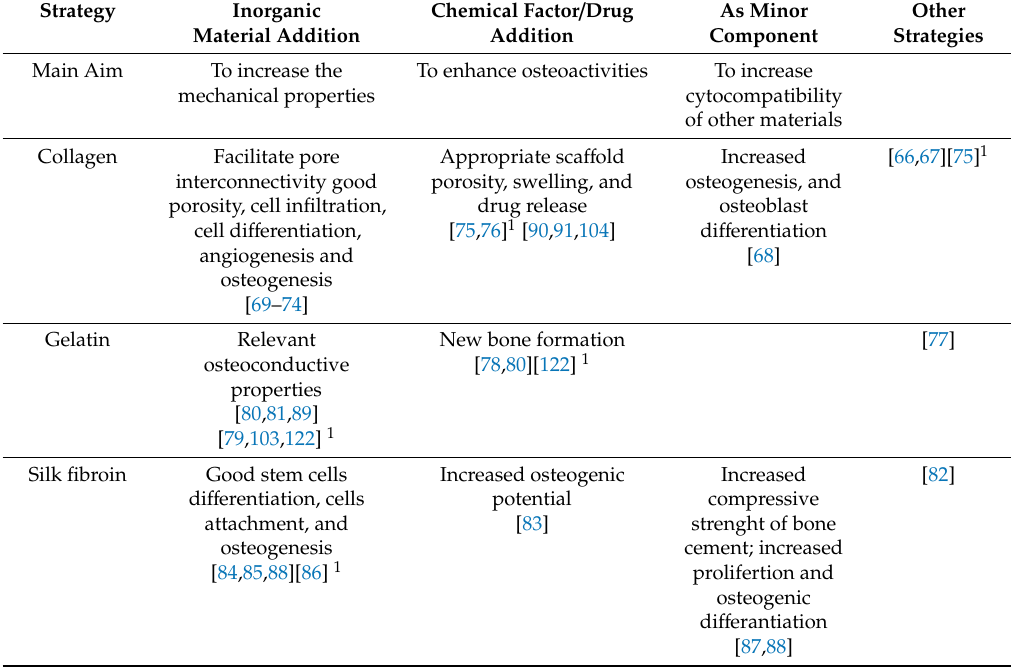
Table 5. In vitro and in vivo experiments are classified according to the material and the strategy adopted with the aims of enhancing the sca ff olds performances. In the first row the main strategies used to make the polymers suitable for bone sca ff olds are reported. In the second row, the fundamental common aim for each strategy. All the analyzed studies in this review have been here classified according to both the material and the strategy adopted. In addition to the achieved general aim, the relevant evidences specific for each combination of material and strategy have been resumed in the table. Almost half of the reported studies overcame the polymers main limit of low mechanical feature by addition of inorganic materials (second column). This strategy not only guanteed an increased mechanical strenght but also favored the cells activities, as specifically reported for each material-strategy combination. In the third column, the several studies involving chemical factors / drugs addition to enhance the polymers osteoactivies. In the fourth column are reported the references where polymers - mainly the natural ones - are used as minor component to enhance the bioactivity or as reinforcement (only in silk and cellulose cases) of other bulk materials. Just few studies can not be included according to the described criteria and are reported in the firth column. The residual number of the studies in the “other stretegies” column confirmed the reported strategies as the most applied ones to obtain the ideal sca ff old, that aim to both overcome the polymers limits and enchance their characteristics. The hydrogel / injectable matierals are indicated with 1